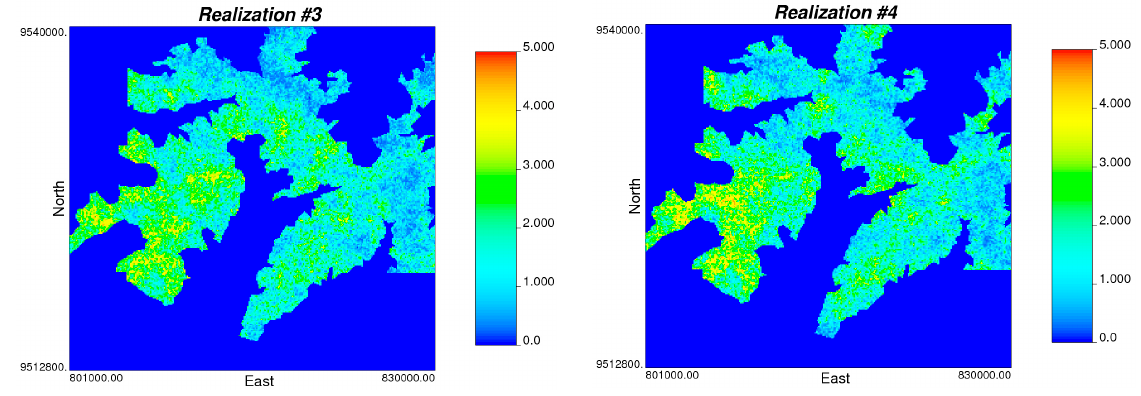
Figure 13. First four realizations on original units.